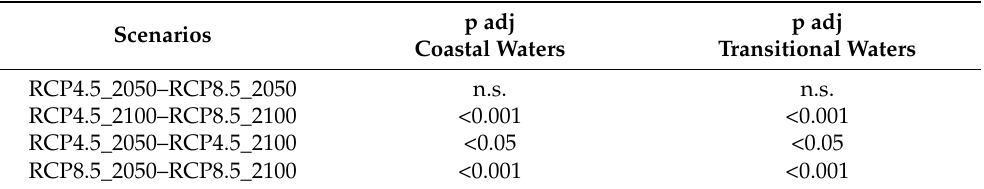
Table 6. Differences among scenarios (RCP 4.5 and 8.5) and timeframes (short: 2040–2050; medium: 2090–2100) in the estimated loss of landings tested by ANOVA followed by Tukey post hoc test. The landing data comprises only the 17 species considered in this study. n.s. = not